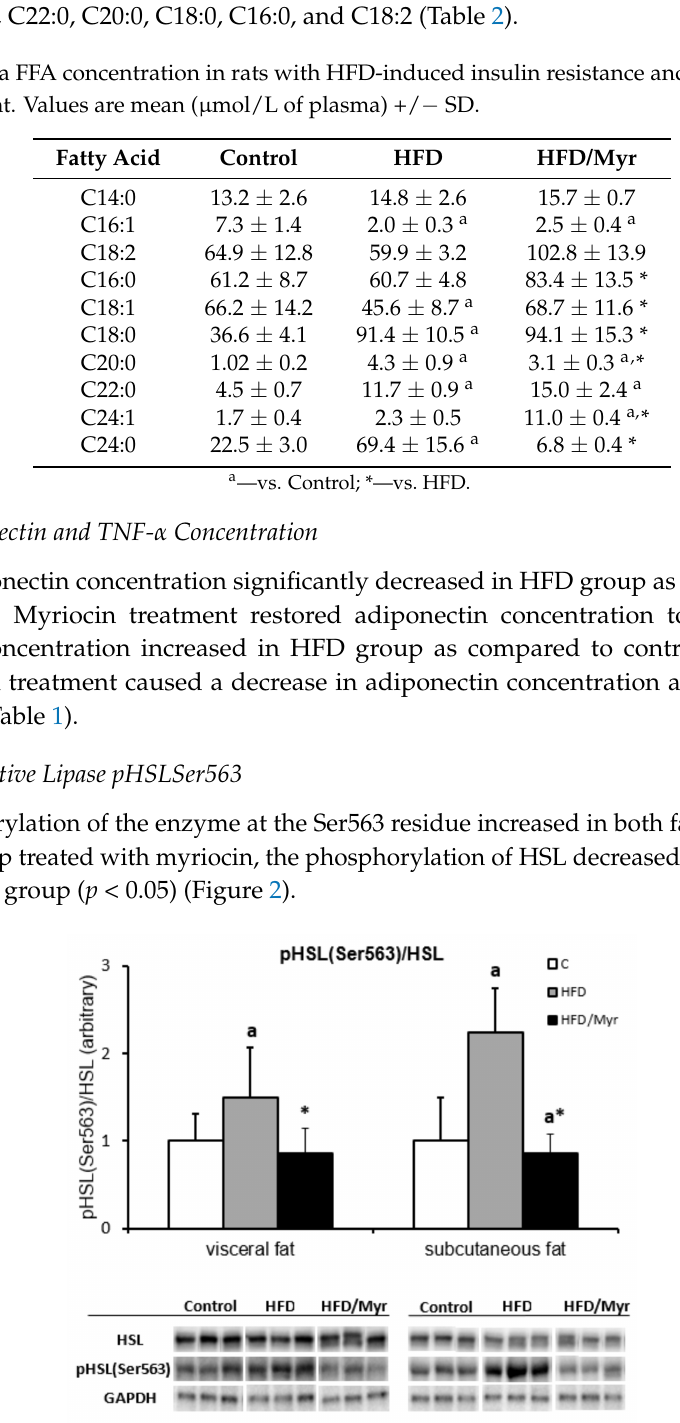
Table 2. Plasma FFA concentration in rats with HFD-induced insulin resistance and under myriocin (Myr) treatment. Values are mean ( µ mol/L of plasma) +/ − SD. Fatty Acid Control